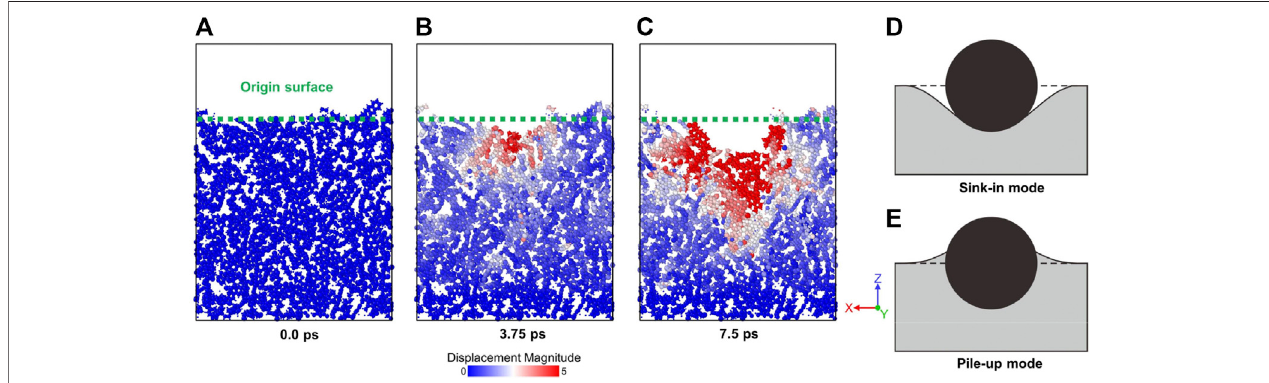
FIGURE7| Surfacemorphologiesofvitrinitesubstrate: (A – C) Variationofsurfacemorphologiesatdifferentloadingstages.Schematicimagesof (D) sink-inand (E) pile-up surface morphologies.